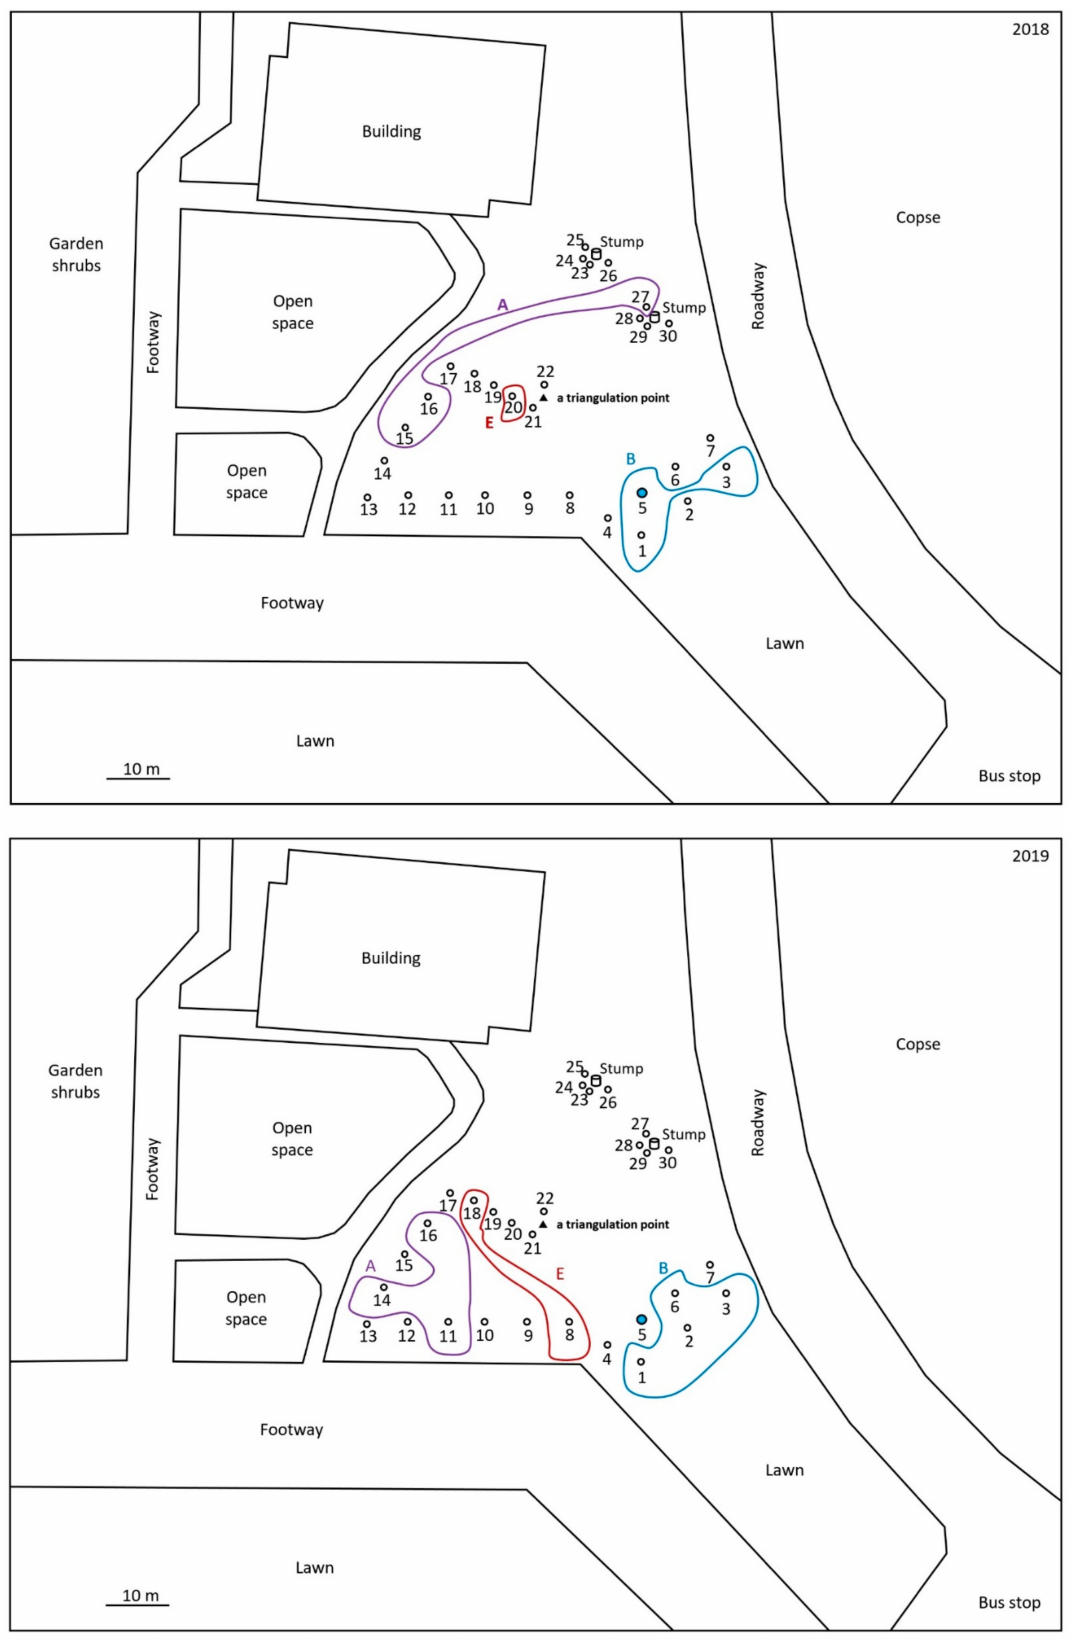
Figure 6. Location of monitoring stations occupied by Reticulitermes speratus at Kindai University from 2013 to 2019. Stations with residing termites from the same population are encircled and labeled A, B, C, D, and E. Station 5, around which discontinuous soil treatment was carried out, is highlighted in